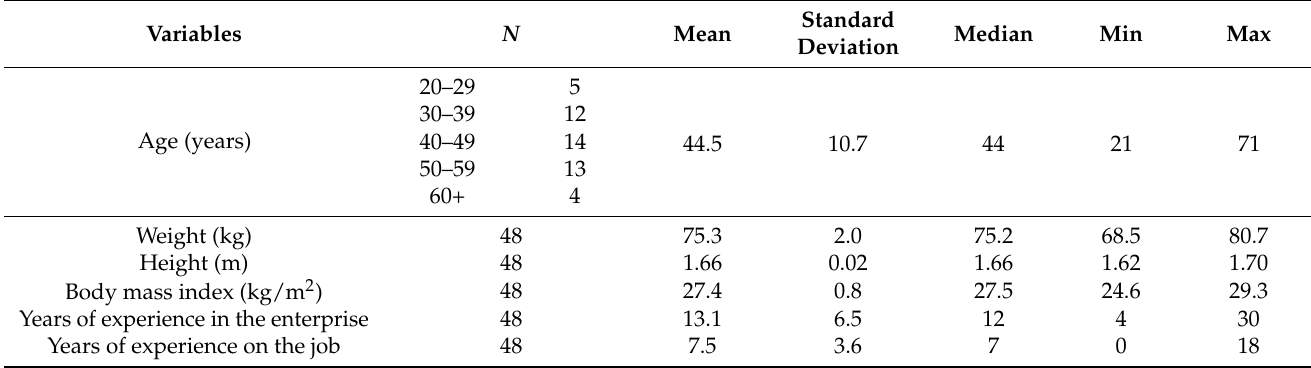
Table 2. Demographic and laboral data of participants in numerical